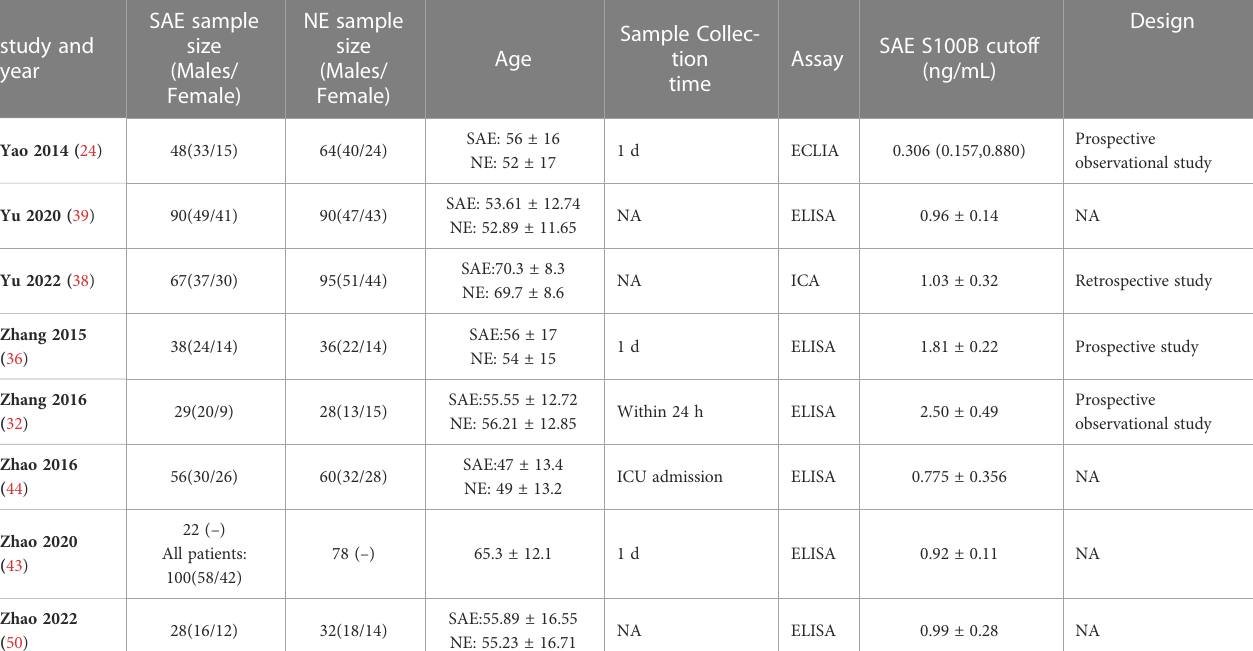
ECLIA, ICA/FICA, and other assays) which displayed in Figure 6 and Figure 7. The subgroup analysis results suggested that different serum sample collection times (collection time ≤ 24h: I 2 = 100%,